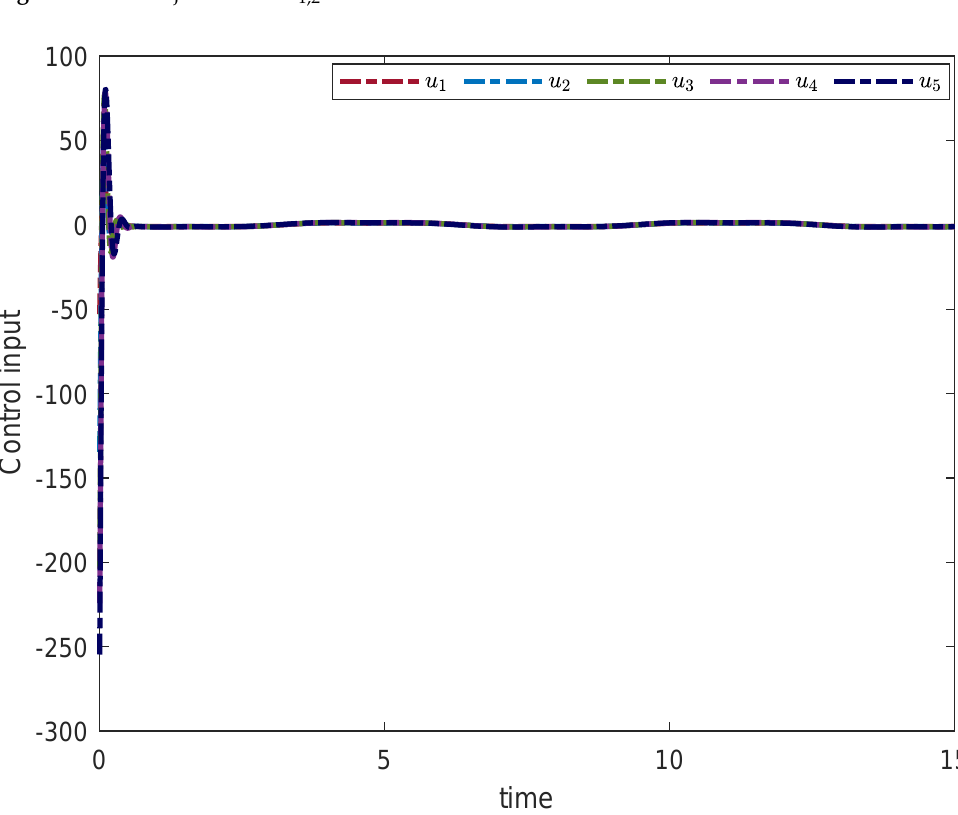
Figure 10. The trajectories of x 1,2 and its estimation.